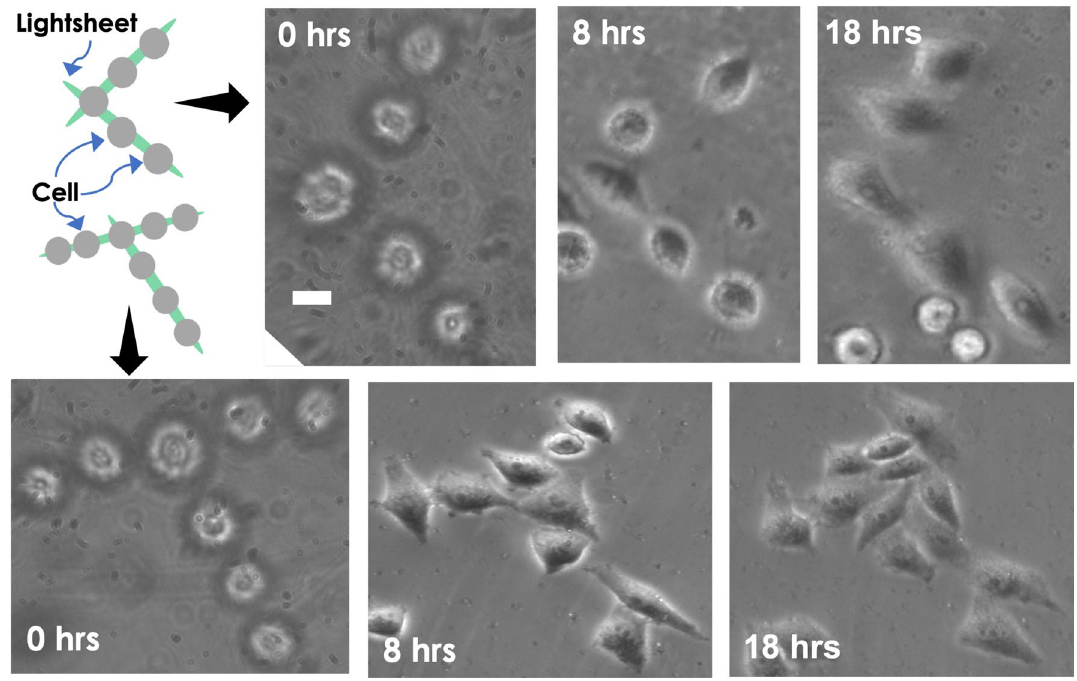
Figure 7. HeLa cells patterned in specific shapes (L and T). Subsequently, the patterned cells were cultured for a longer duration (8 h and 18 h) in a standard cell culture incubator maintained at 37 ◦ C and 5% CO 2 . The scale is 5